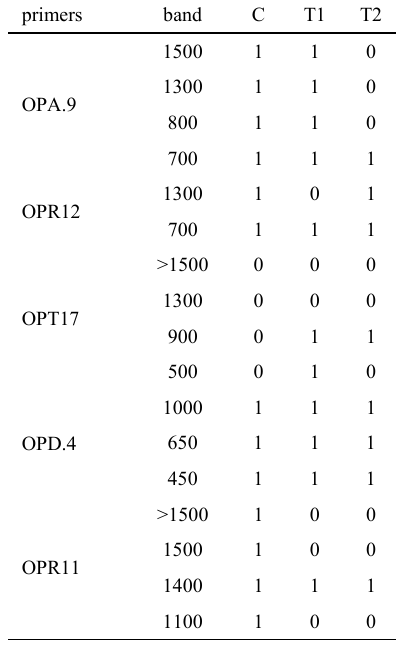
Table 2: Results of banding related to primers of Fig.